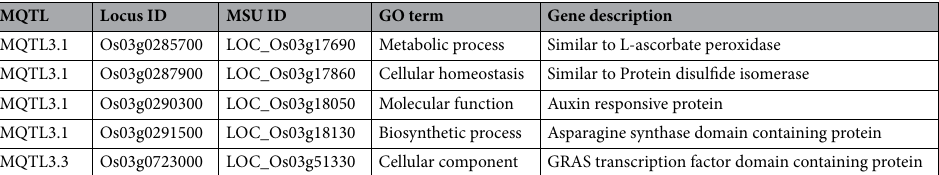
Table 4. Details of candidate genes identified under MQTL regions associated with grain